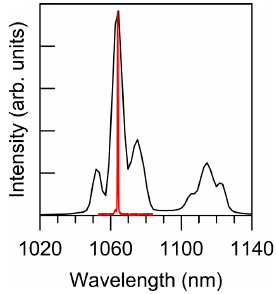
Figure 3. Spontaneous ( black line ) and stimulated ( red line ) emission spectra of Nd:YAG crystal powder (stimulated emission intensity is several orders of magnitude higher).